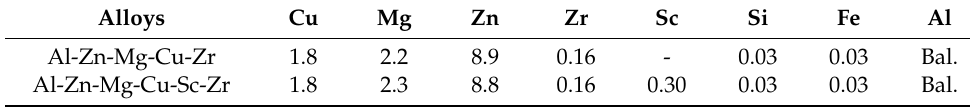
Table 1. Chemical compositions of the researched alloys (in wt.%).